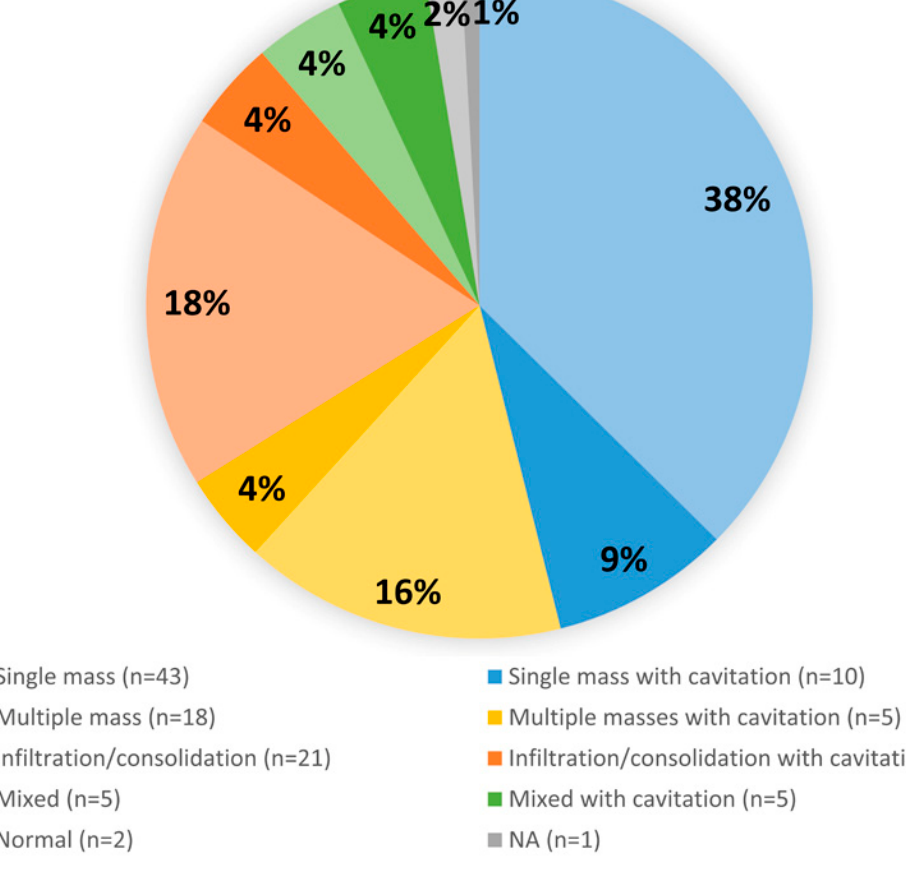
Figure 5. Analysis of radiological